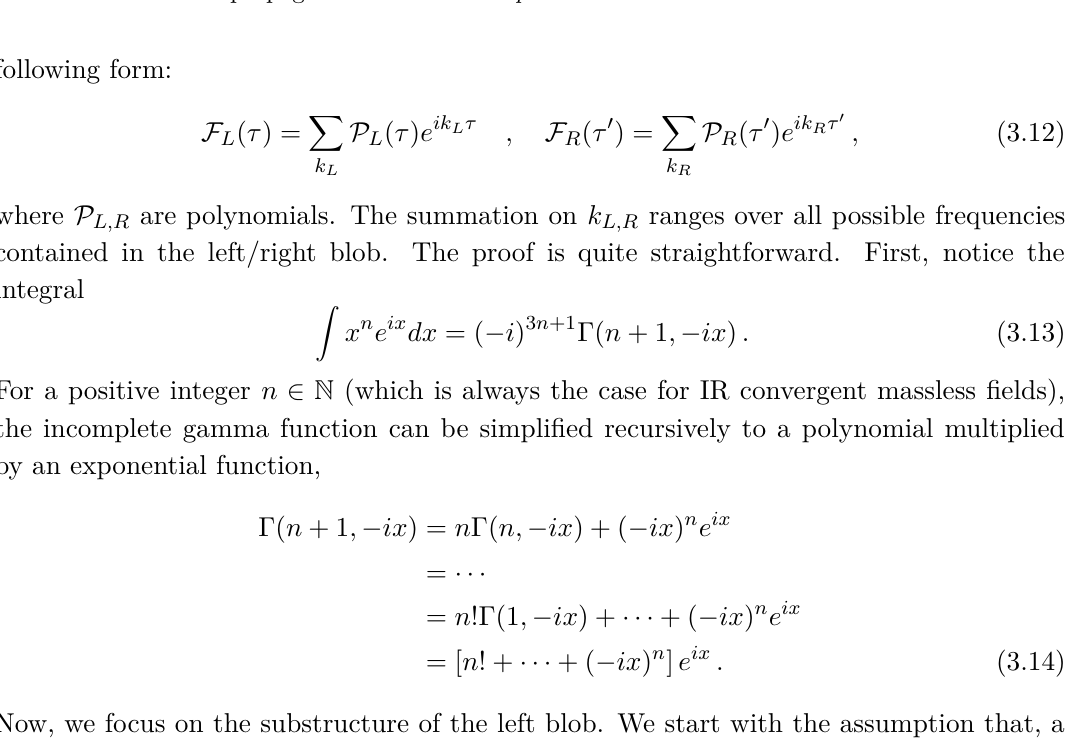
Figure 5 . A larger left blob L 1 ∪ L 2 can be constructed by gluing the roots of two smaller blob trees with a massless propagator of momentum p